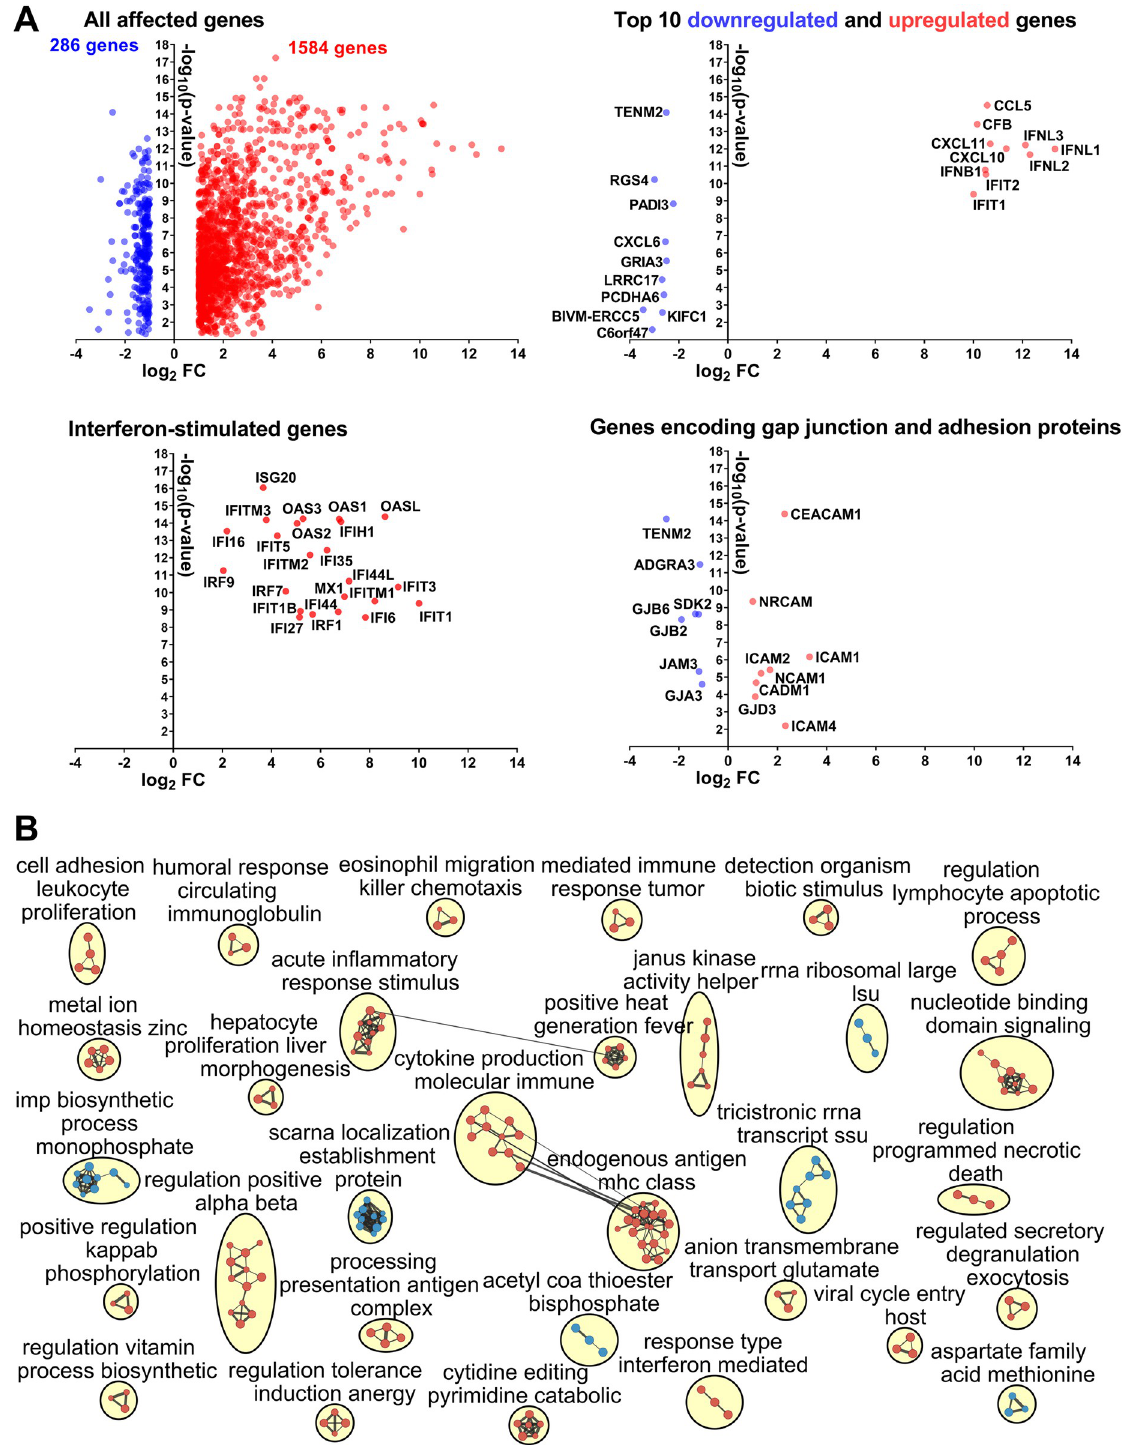
Fig 2. Cellular transcriptional responses during JEV infection in human primary vaginal epithelial cells. ( A ) Cellular transcriptional responses in human primary vaginal epithelial cells during JEV infection. Plots of the upregulated (red) and downregulated (blue) genes. All affected genes, top 10 affected genes, interferon-stimulated genes, and genes encoding gap junction and adhesion proteins with FDR- adjusted p < 0.05 and log2 fold change (FC) > 1 are shown. See raw data in S1A Table . ( B ) Molecular pathology network in human primary vaginal epithelial cells during JEV infection. An enrichment map of significantly altered GO biological processes is shown. Red are pathways with positive and blue are with negative enrichment. All subnetworks with FDR-adjusted p < 0.05 and at least three connected nodes are shown. See raw data in S1B Table